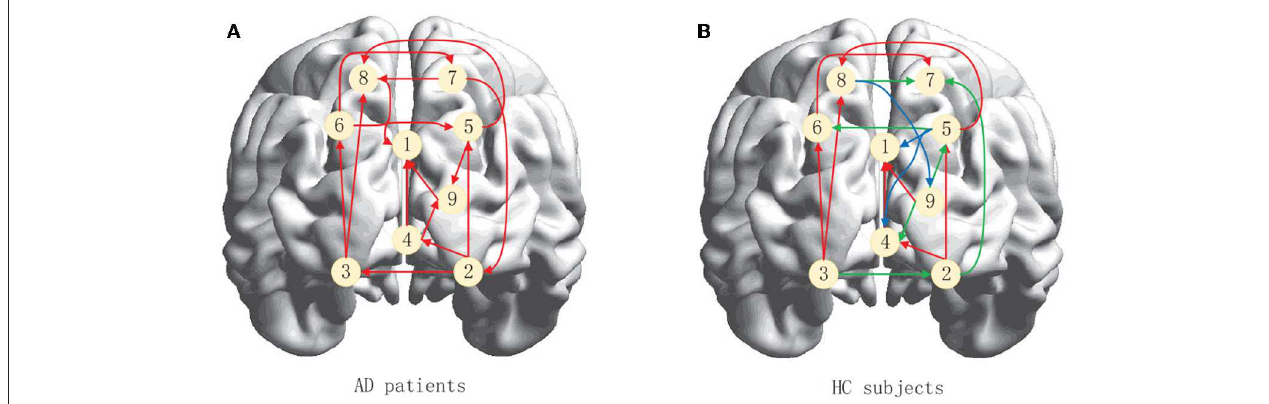
FIGURE 9 | Brain effective connectivity networks learned by ACOEC-FD. (A,B) are graphical illustrations of the brain effective connectivity networks for AD patients and HC subjects, respectively. The red arrows in (B) indicate that the effective connectivity is the same as (A) , whereas blue arrows show additional connections, while green arrows show reversed